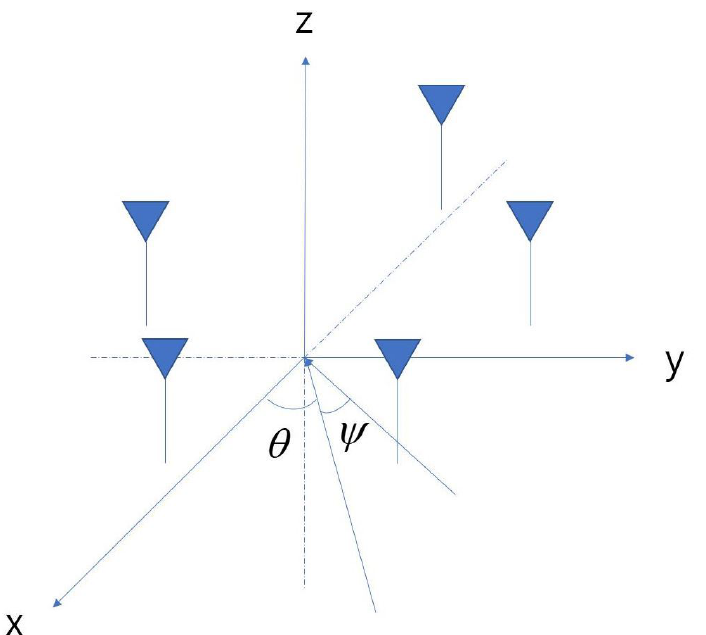
Figure 1. This figure shows Uniform Circular Array (UCA). The two-dimensional array can simulta- neously estimate azimuth and elevation of signal